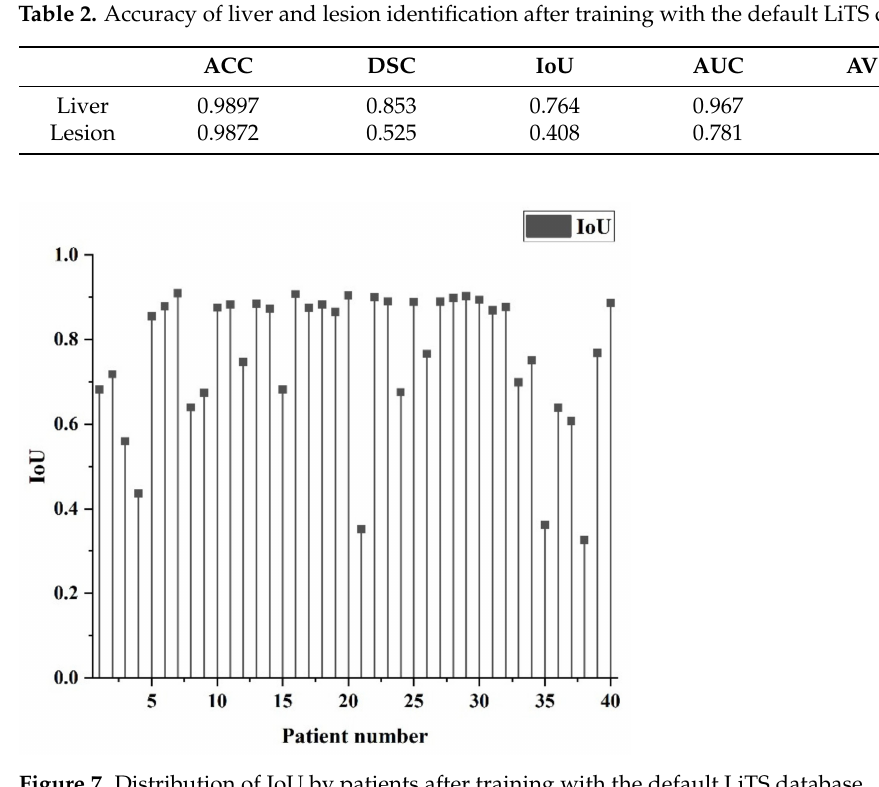
Figure 7. Distribution of IoU by patients after training with the default LiTS database.